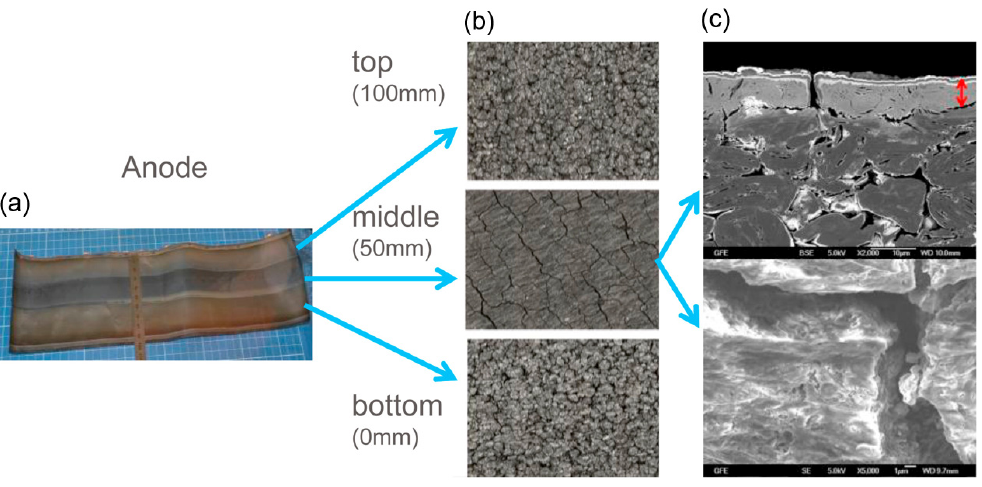
Figure 9. Optical microscope images of the aged cells: ( a ) photo of the anode; ( b ) laser microscope images; ( c ) SEM images [65]. Reprint with permission [65]; Copyright 2017,